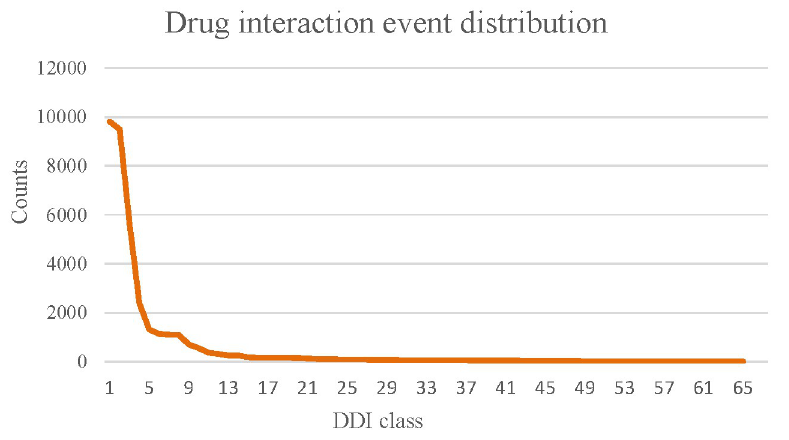
Fig 3. Statistical analysis of the DDI class